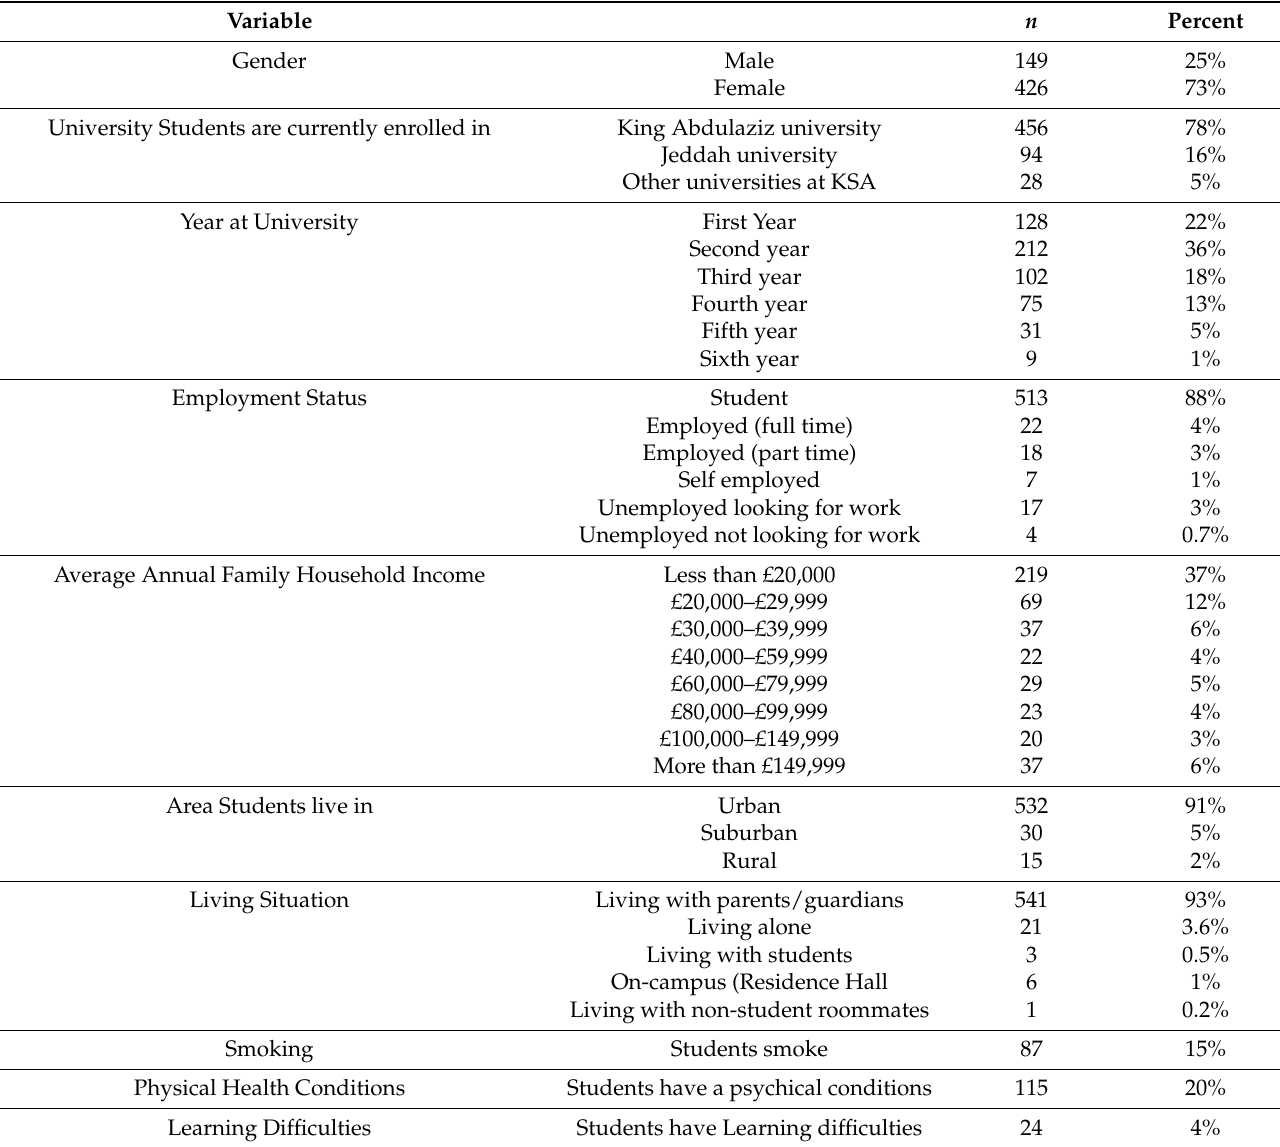
Table 1. Undergraduate students’ demographic